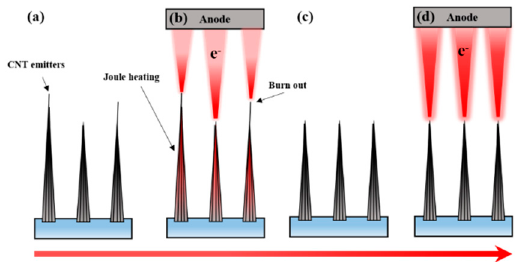
Figure 1. Schematic diagram of electrical aging technology. ( a ) Non-uniformity of height and crystallinity before aging; ( b ) electrical aging with Joule heating; ( c ) homogenization of height and crystallinity; ( d ) stable electron field emission by structural improvement.